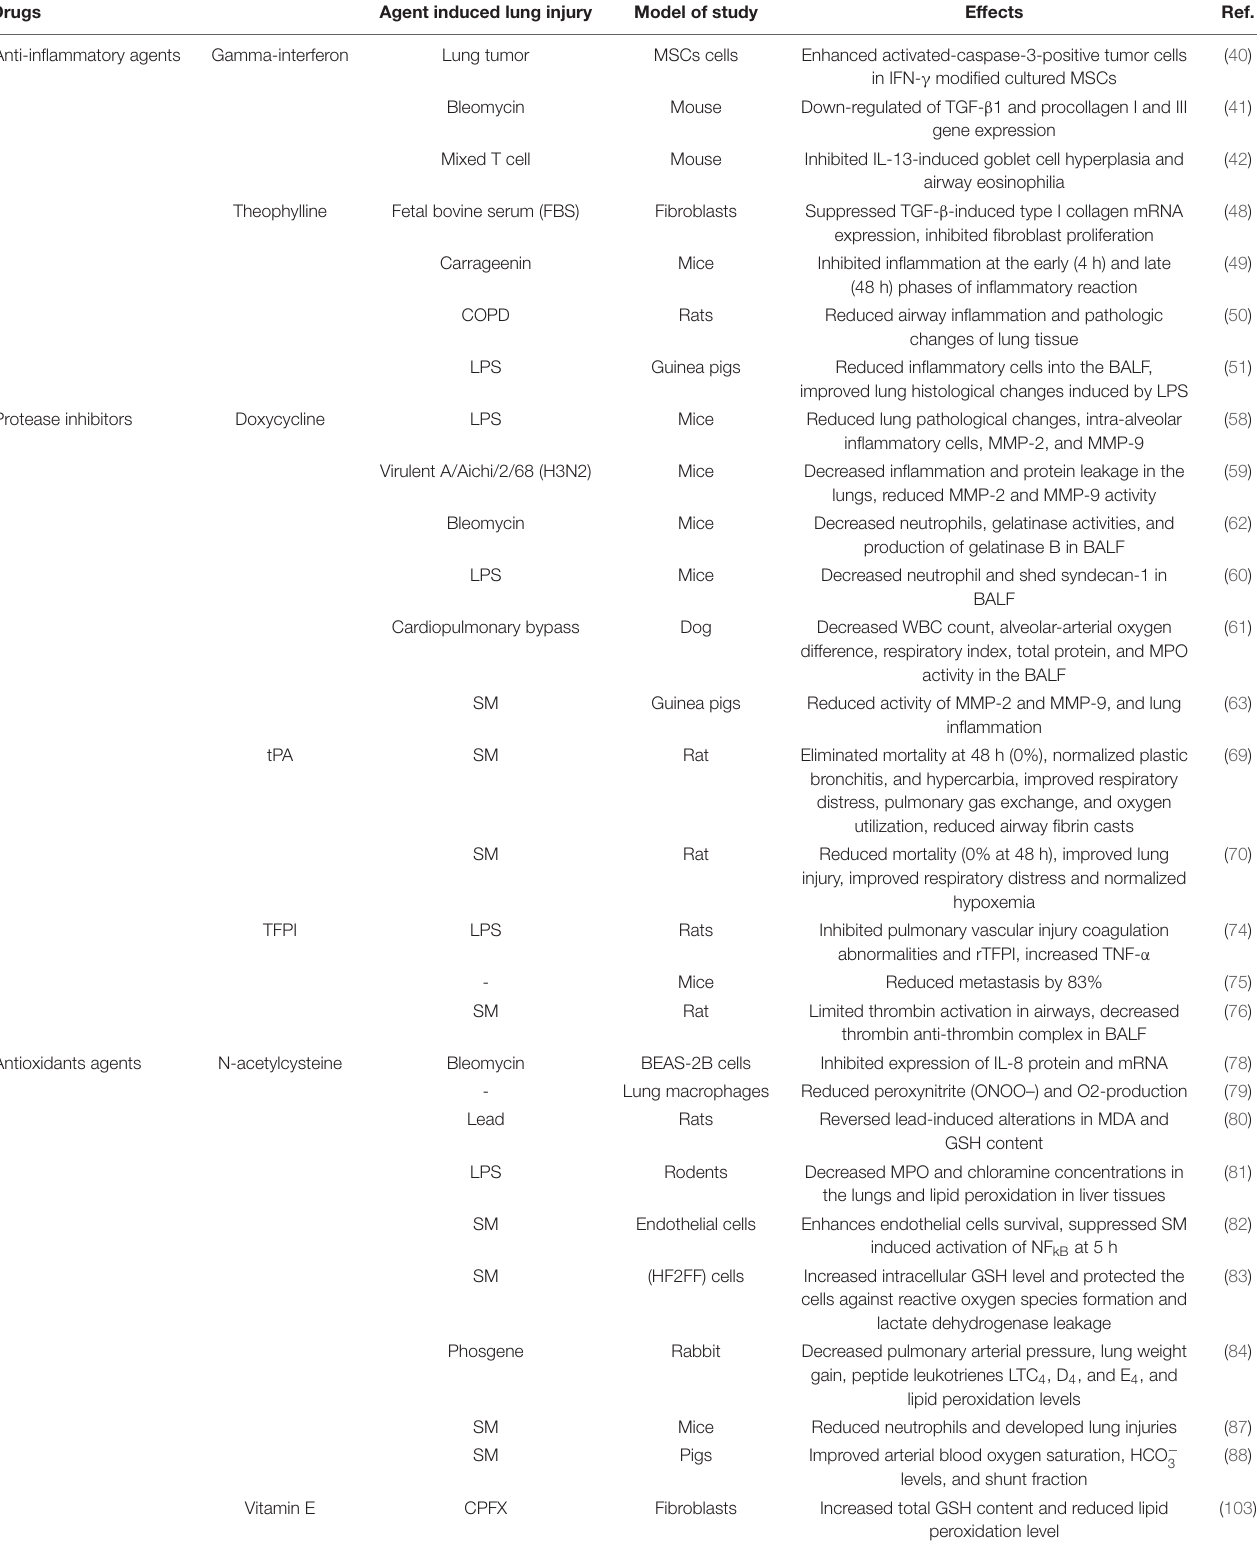
TABLE 1 | Therapeutic effects of pharmaceutical drugs on SM-induced lung injuries, experimental evidence. Drugs Agent induced lung injury Model of study